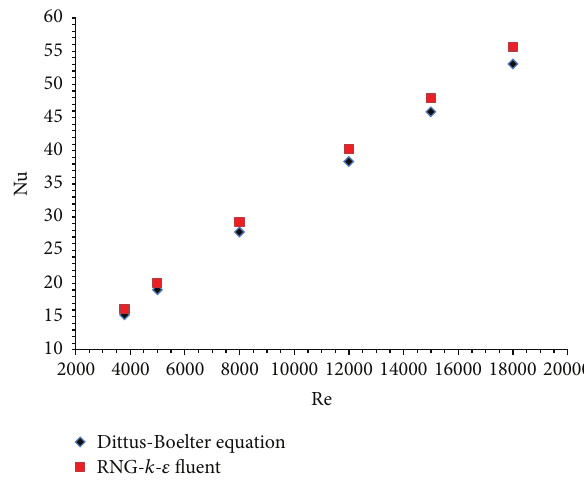
Figure 4: Validation of Dittus-Boelter empirical correlation with RNG- 𝑘 - 𝜀 FLUENT model.